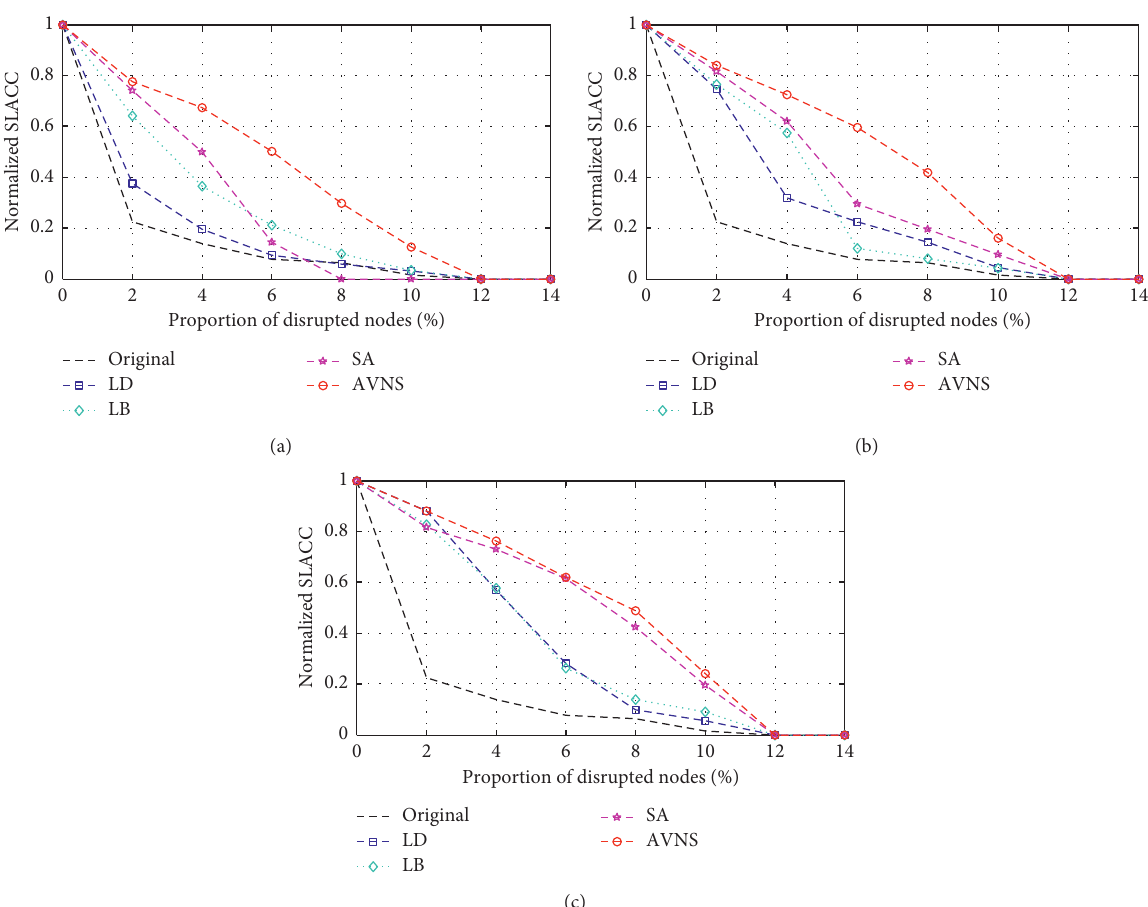
Figure 7: Responses of chain 14 and reconfigured ones facing target disruptions. (a) f